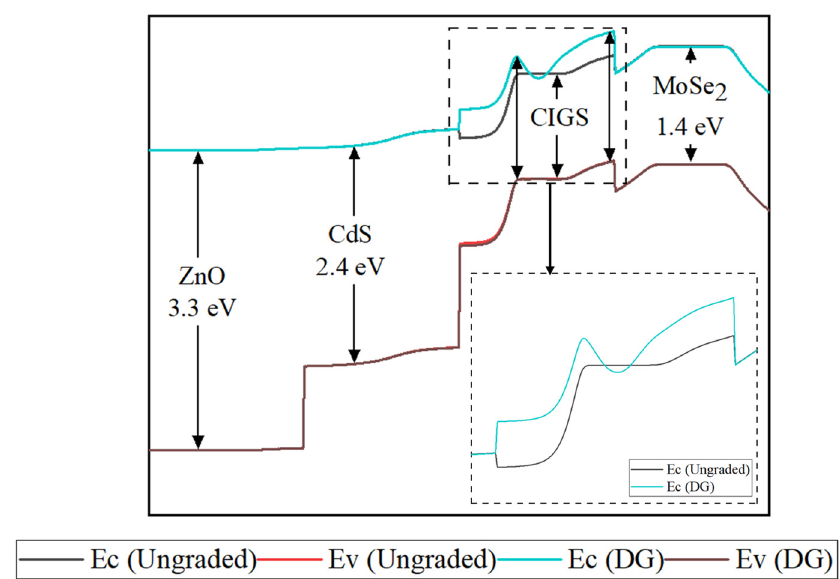
Figure 2. Schematic view of the band diagram of ZnO/CdS/CIGS/MoSe 2 layers in the SCAPS model, with double grading (DG) bandgap profile in the CIGS absorber. Inset: Close-up view of how the double grading (DG) is incorporated in the model. DG is modelled as conduction band ( 𝐸 (cid:3004) ) minimum rises from a determined notch position towards the back and front of CIGS absorber. Table 2. The Variation in Grading Parameters Simulated.